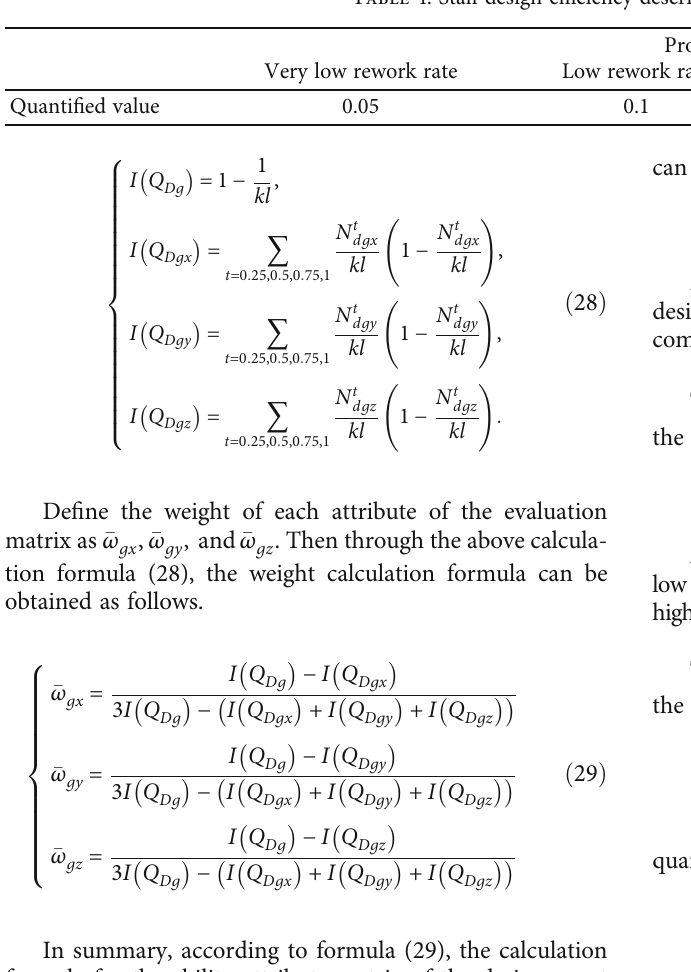
Table 4: Sta ff design e ffi ciency description quantitative